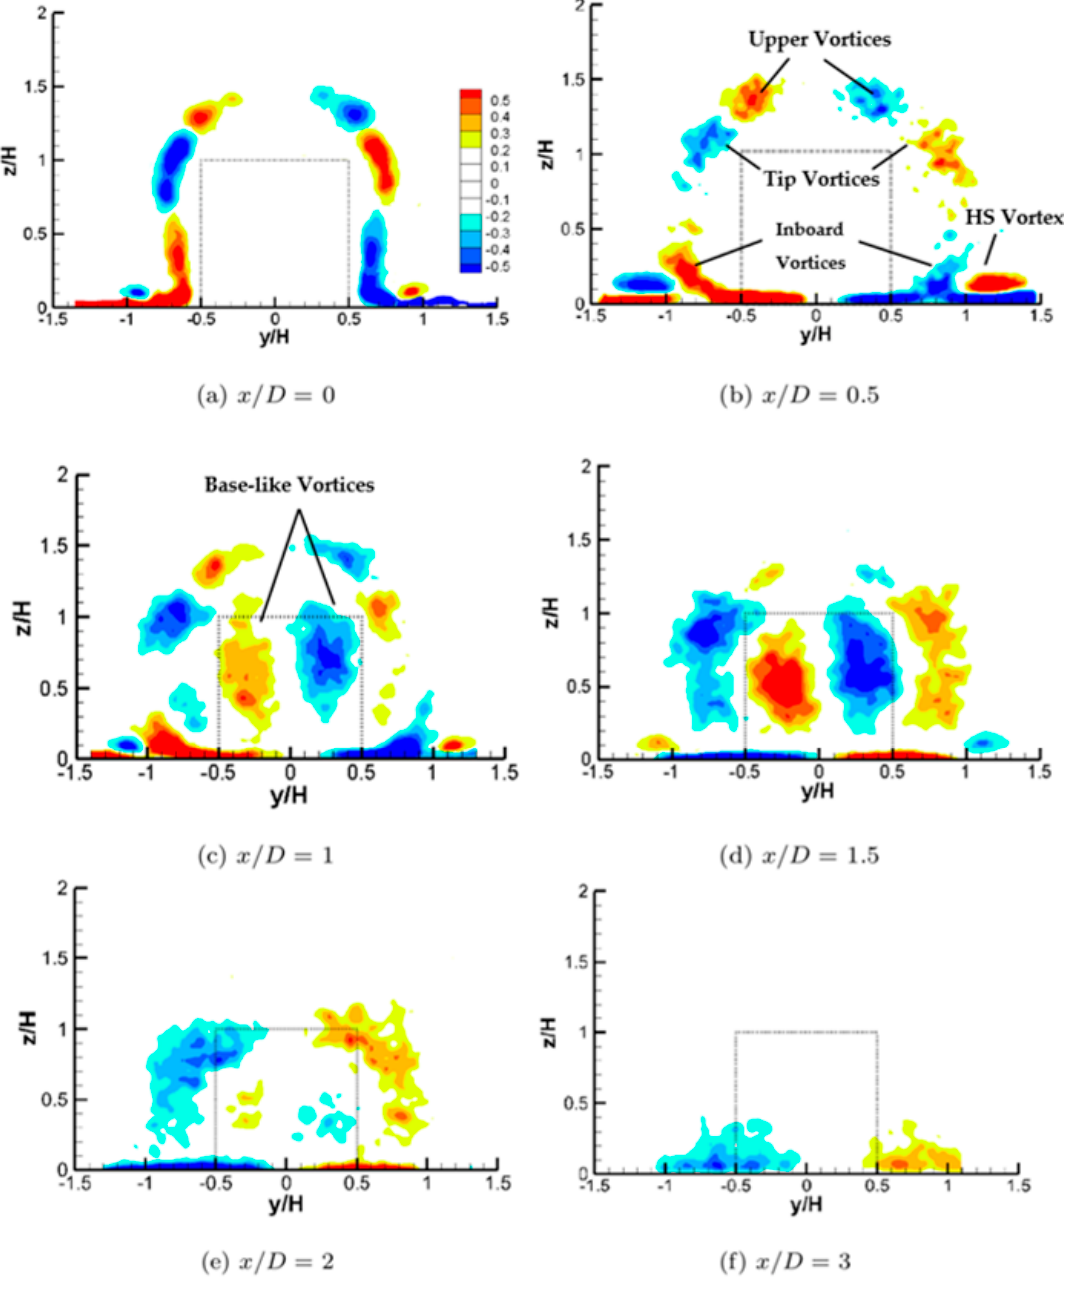
Figure 4. Dimensionless, time-averaged, streamwise vorticity, ω x * = ω x H / U , in the wake of cube in x / D = x / H = 0, 0.5, 1.0, 1.5, 2.0, and 3.0. Red shades represent positive counter-clockwise vorticity, blue shades represent negative clockwise